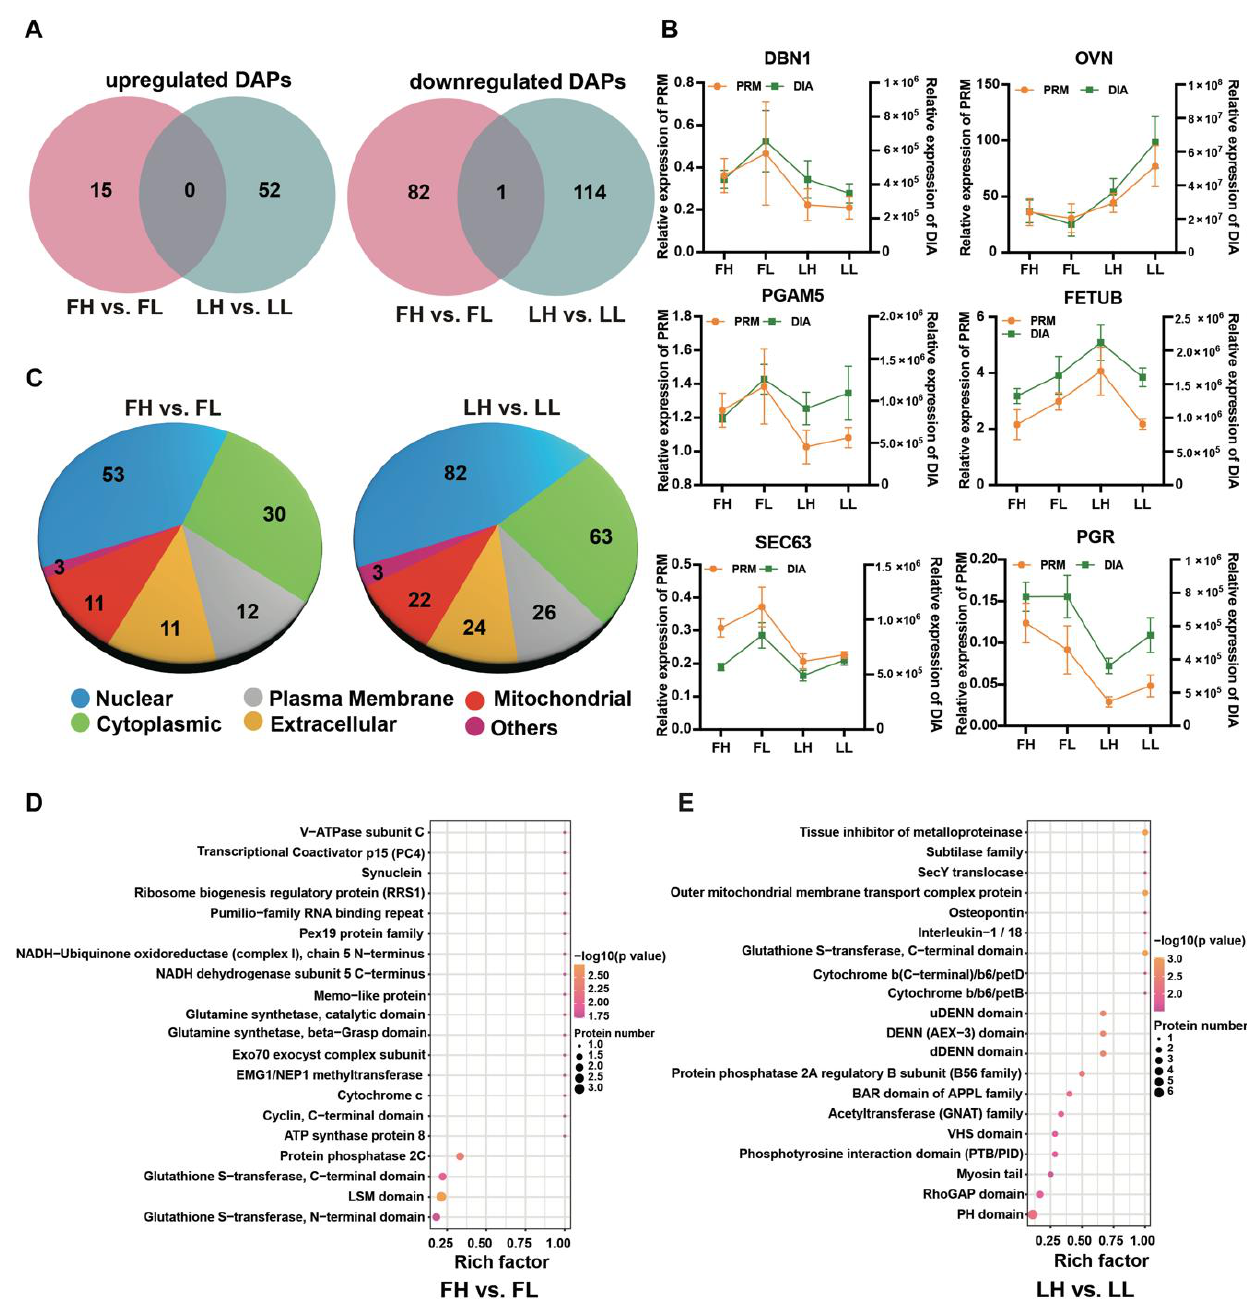
Figure 4. Functional annotation analysis of differentially abundant proteins (DAPs). ( A ) Venn diagram of DAPs identified between the follicular phase and luteal phase in the oviduct. ( B ) Validation results of six selected proteins in the four groups (FH, FL, LH, and LL) by parallel reaction monitoring (PRM). ( C ) Subcellular localization of DAPs in the different comparison groups. ( D , E ) Domain enrichment analysis of DAPs in the FH vs. FL ( D ) and LH vs. LL ( E ) comparison groups.